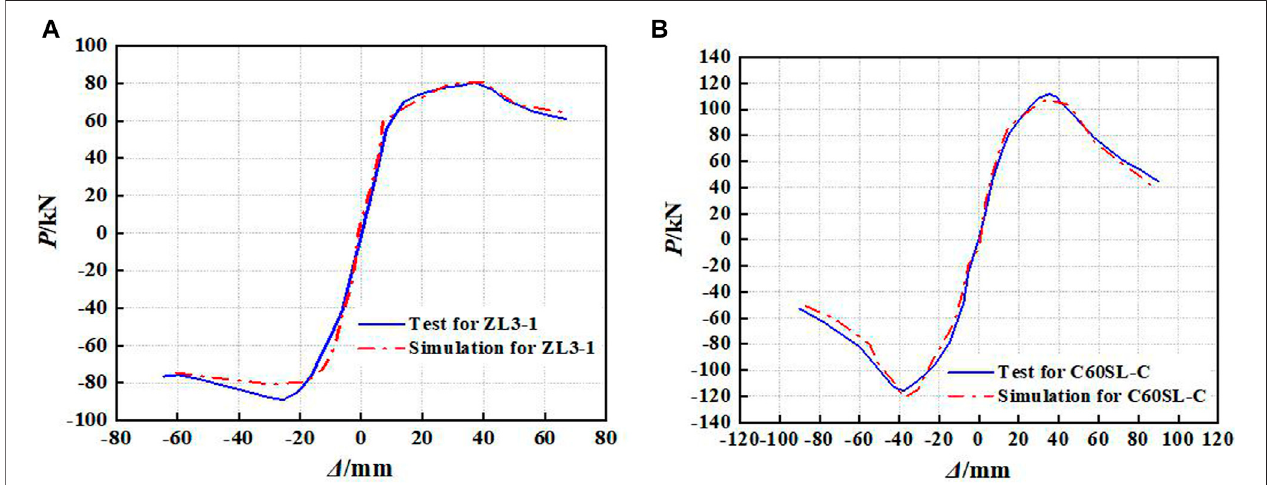
FIGURE 6 | Comparisons of skeleton curves between test and simulation: (A) specimen ZL3-1; (B) specimen C60SL-C.